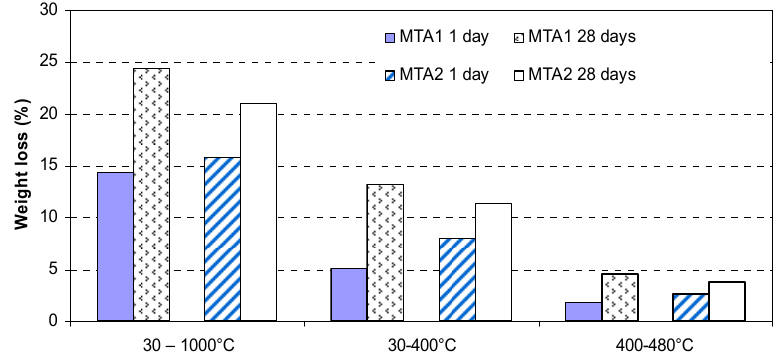
Figure 7. Weight losses recorded on TG curves of MTA cement pastes hydrated for 1 day and 28 days.